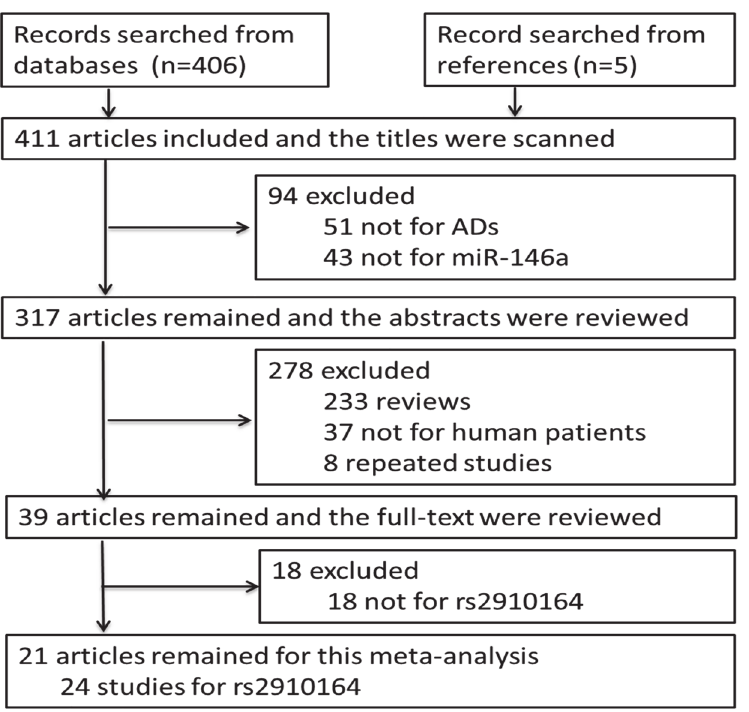
Fig 1. Flowchart for identification of studies included in the meta-analysis. In 411 articles, 51 were found not related to ADs and 43 were found not related to miR-146a by scanning the titles. After that, 233 articles were recognized as reviews, 37 were found not related to human patients and 8 articles were repeated papers by reviewing the abstracts. The full-texts of the left 39 articles were carefully reviewed, in which 18 articles were found not about rs2910164. At last, 21 articles were remained for this meta-analysis, which included 24 case-control studies for